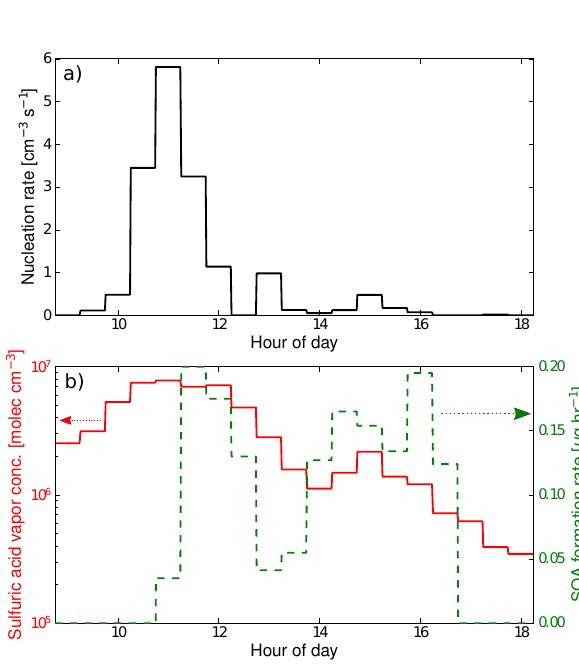
Fig. 1. (a) Nucleation rate and (b) the sulfuric acid vapor concen- tration and SOA formation rates used as inputs to the Hyyti¨al¨a 10 April 2007 box-model simulations. Nucleation rates are derived from SMPS data, sulfuric acid concentrations are from CIMS and the SOA mass formation rates are derived from AMS data. See text for